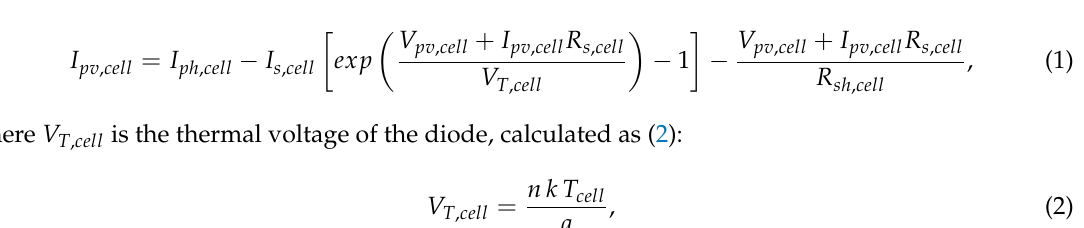
Figure 2. Five-parameter equivalent circuit of a PV